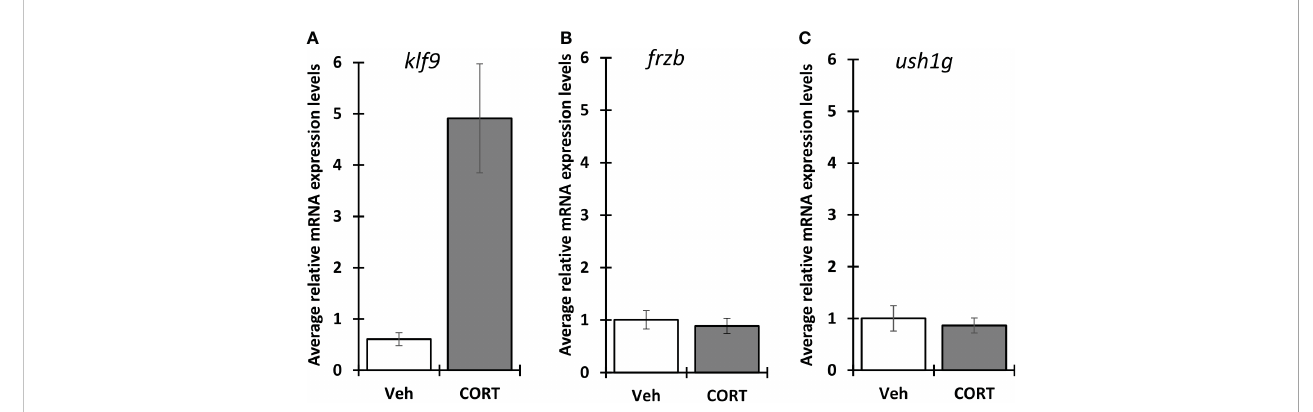
FIGURE 7 Induction of klf9 , frzb and ush1g in X. laevis . Premetamorphic (NF 54) X. laevis tadpoles were treated with vehicle control or 100 nM CORT (corticosterone) for 24 hours followed by tail RNA extraction and quantitative PCR to quantify mRNA expression of klf9 (A) , frzb (B) , and ush1g (C) . Bars represent mean mRNA levels relative to the housekeeping gene rpl8 and normalized to a vehicle control sample. n = 10 tail samples per treatment. Error bars represent SE. Letters indicate signi fi cant groups, p <